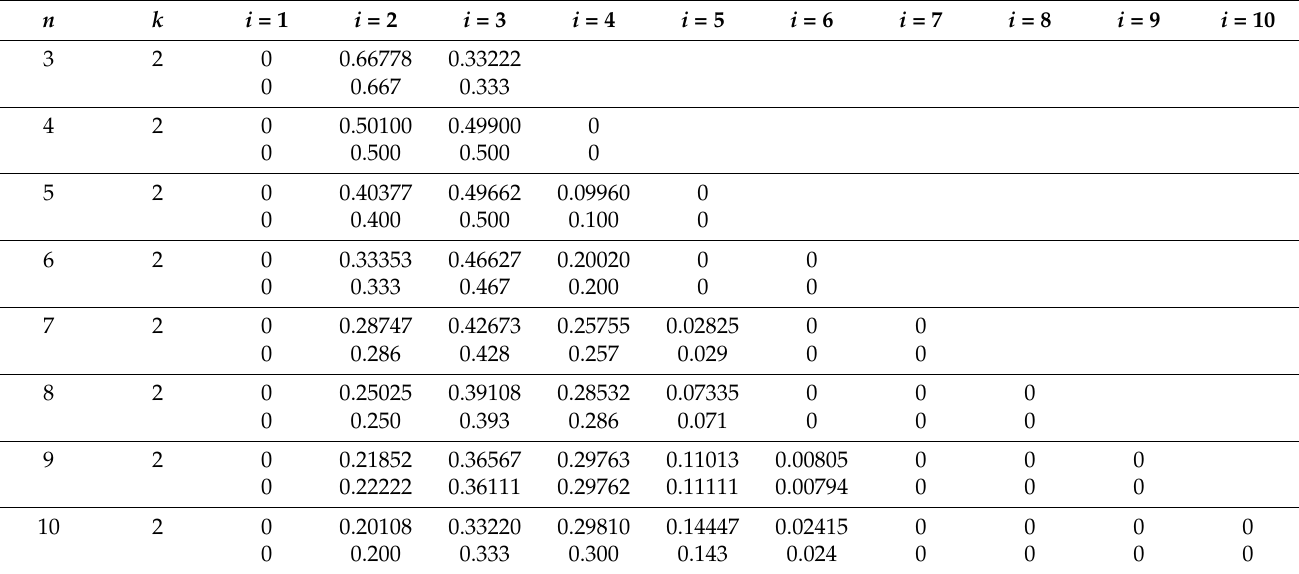
Table 1. Accurate and simulation-based signatures of the weighted-2-within-consecutive-2-out-of- n : F system for specific designs.